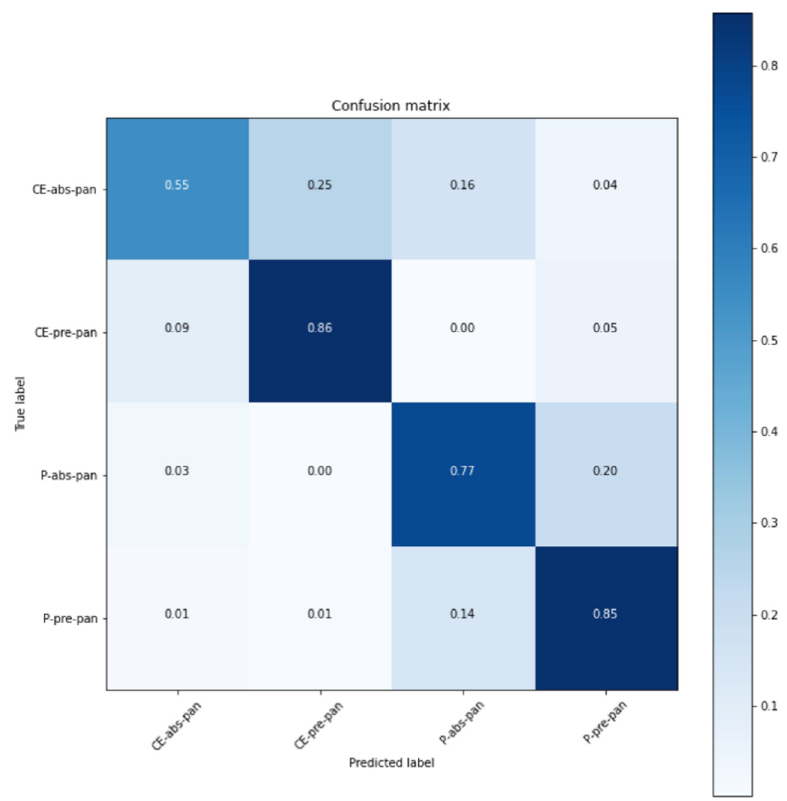
Figure 11. Confusion matrix of A1-7. (CE: contrast-enhanced, P: plain).